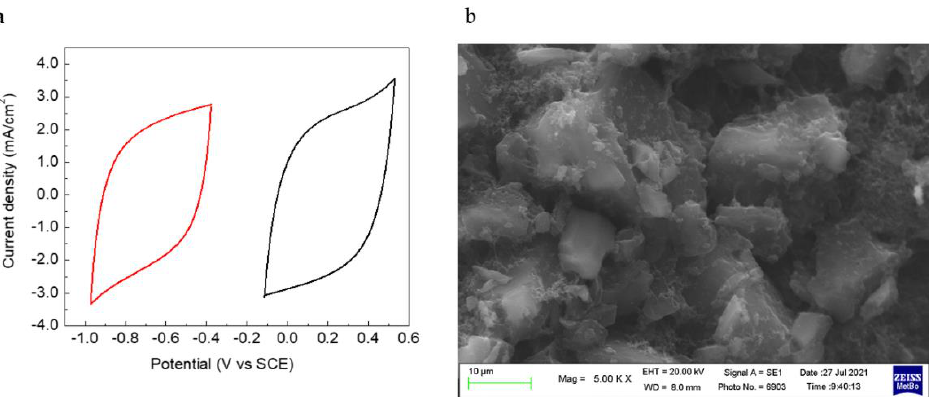
Figure 6. ( a ) CV curves of AC electrodes in Na 2 SO 4 electrolyte and ( b ) SEM image of pristine AC electrodes surface.